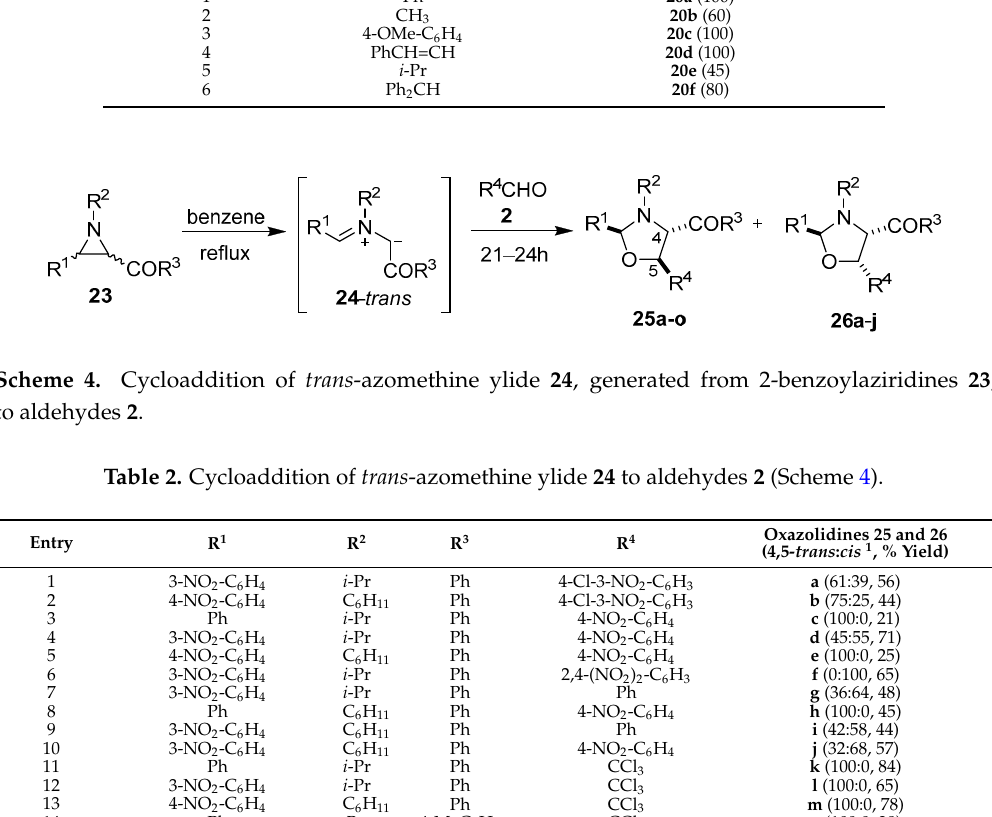
Table 3. Cycloaddition of the azomethine ylides derived from aziridines 23 to diphenylcyclopropenone ( 3a ) (Scheme 5).